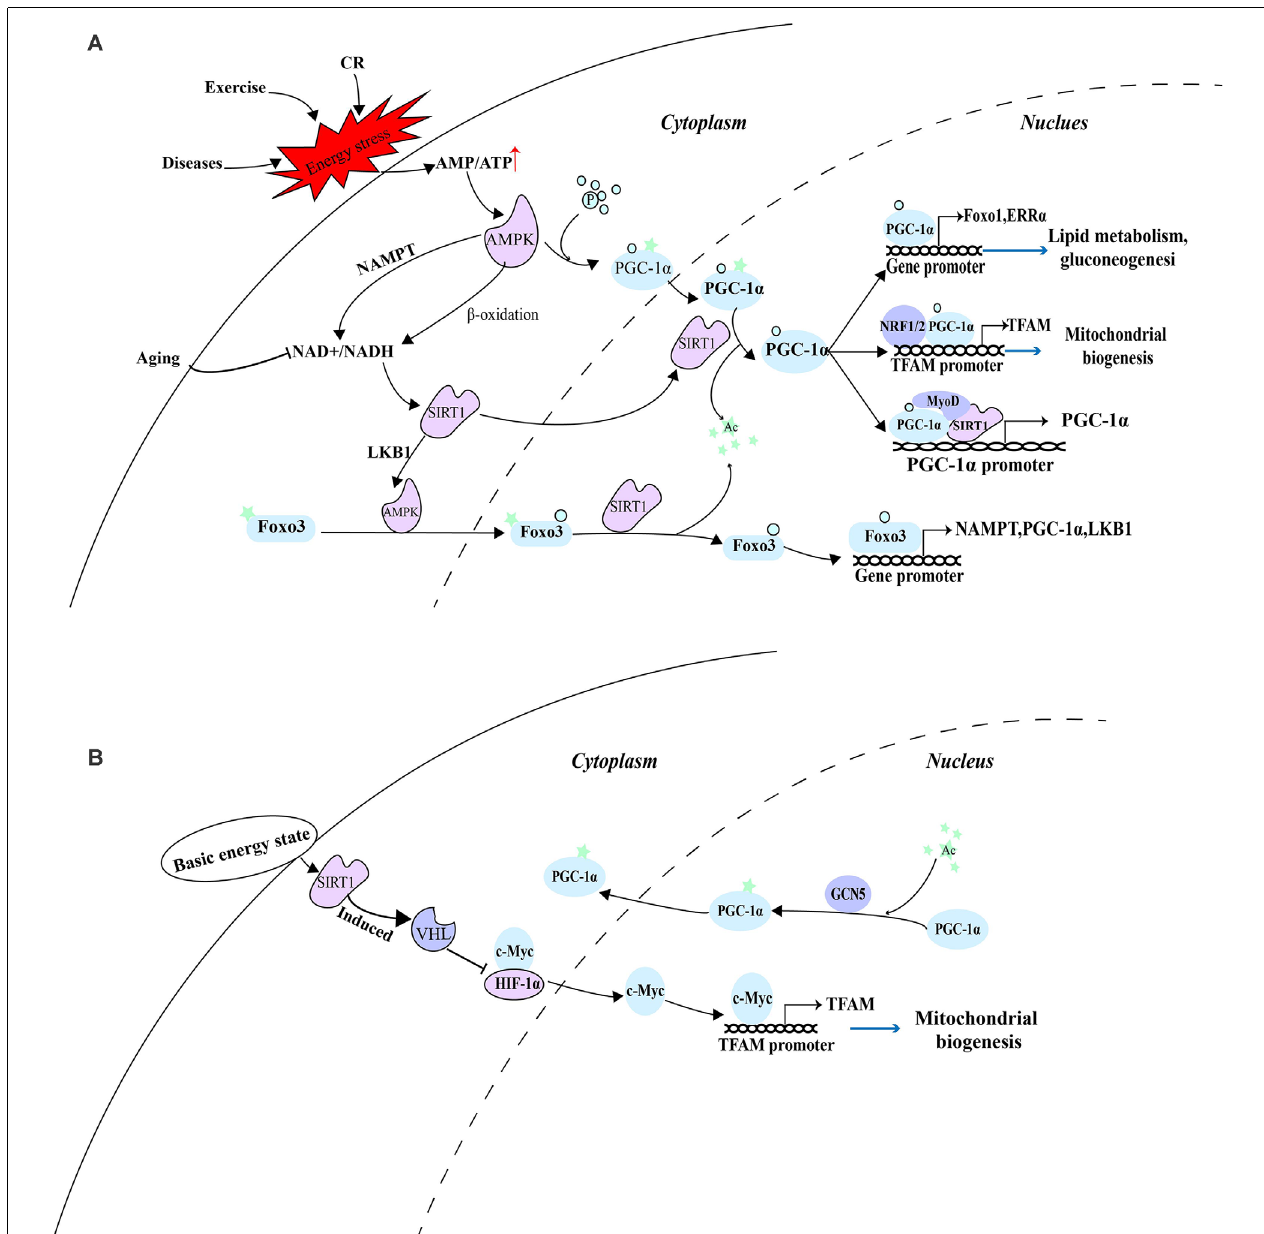
FIGURE 1 | AMPK as a switch of energy state-mediated pathway. (A) Under a low-energy state, activated AMPK depends on the SIRT1-PGC-1 α axis to eliminate cellular energy stress. (B) Under the basic energy state, SIRT1 regulates mitochondrial biogenesis through a pathway independent of AMPK and PGC-1 α .